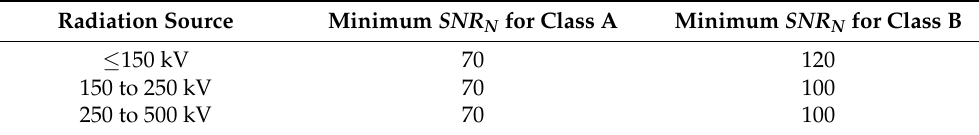
Table 4. Minimum SNR N values for the digital radiography of aluminum, magnesium, and